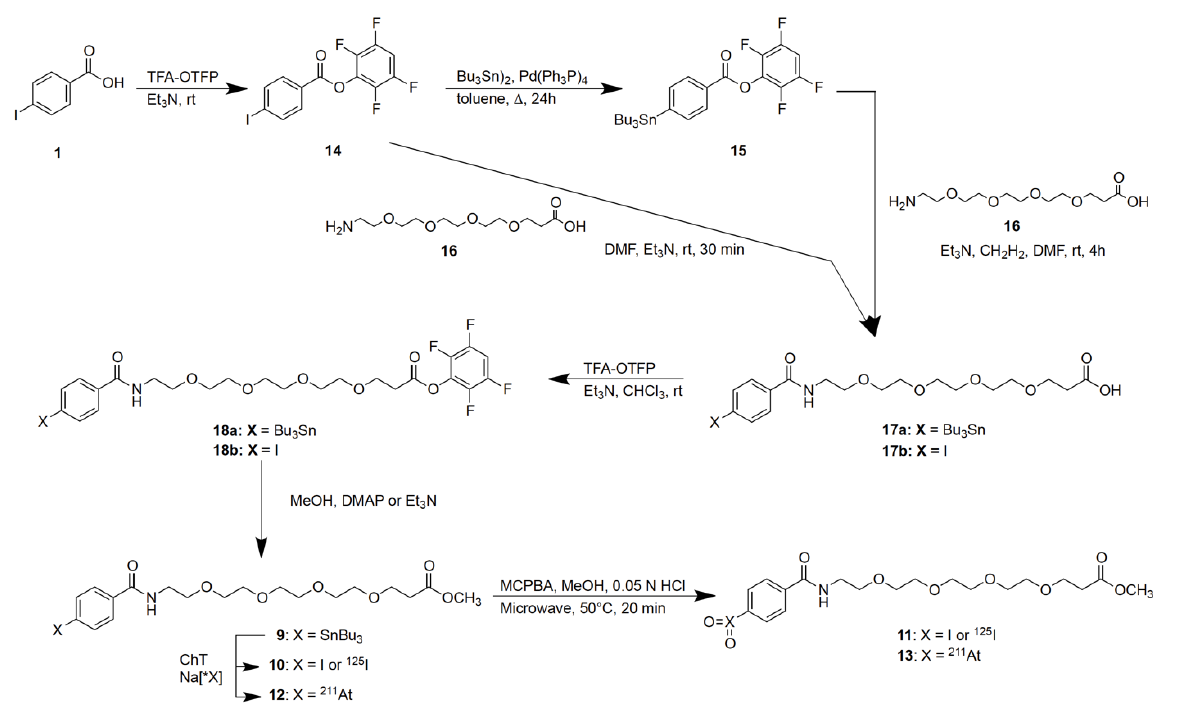
Figure 3. Synthetic scheme for the preparation of p -(radio)halobenzamidyl-dPEG 4 -carboxylic acid methyl ester derivatives 9 – 12 and subsequent oxidation to form [ 125 I] 11 and [ 211 At] 13 .